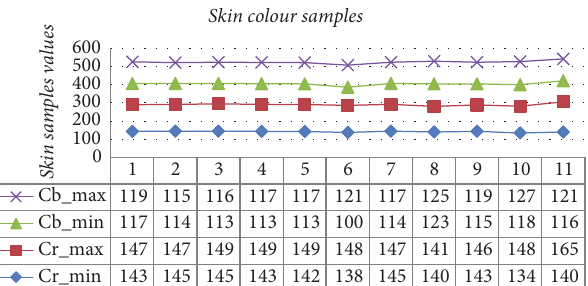
Figure 4: The threshold factors obtained using offline training procedure for skin